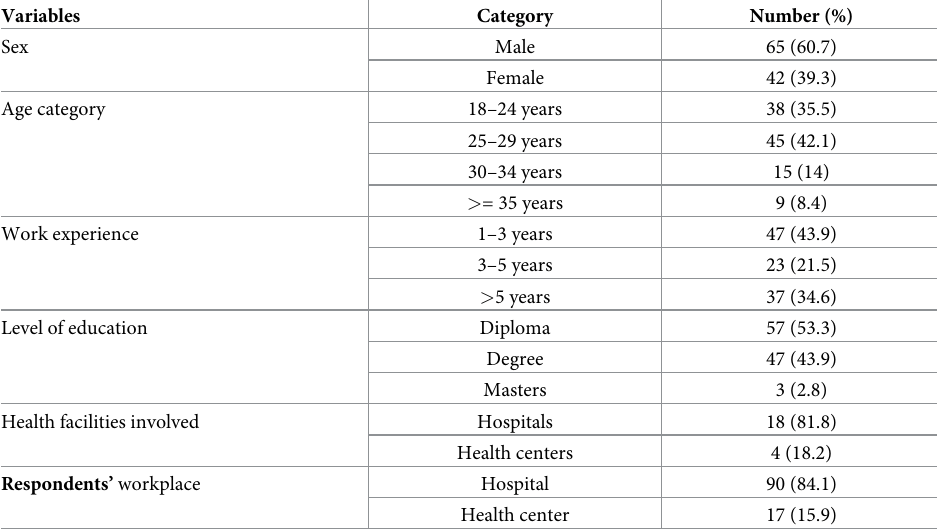
Table 1. Sociodemographic characteristics of respondents, northeast Ethiopia, October 2019 (N =